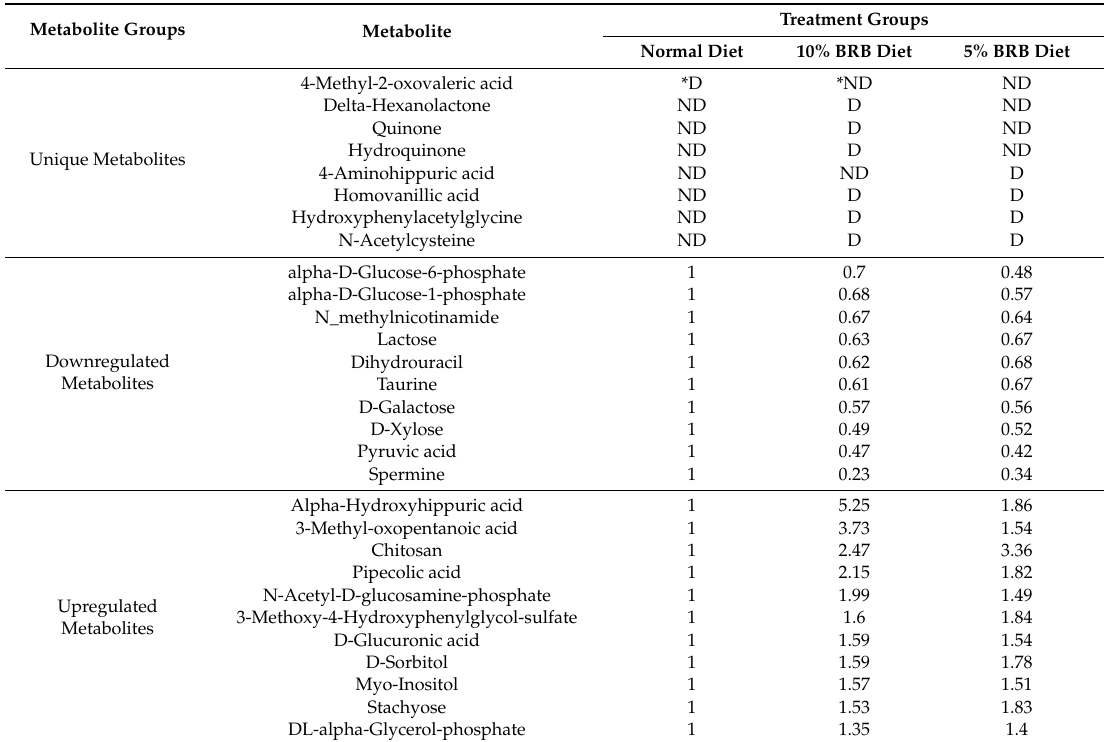
Table 2. Unique and di ff erentially expressed metabolites in the urine samples of 4NQO exposed rats fed the control diet, or diets supplemented with 5% or 10% BRB. Metabolites were identified by ‘Complex Metabolites with quantitative ratios listed were detected in at least two samples per group. Numbers represent the relative quantities of metabolites when compared to the 4NQO-exposed rat group that were fed a normal